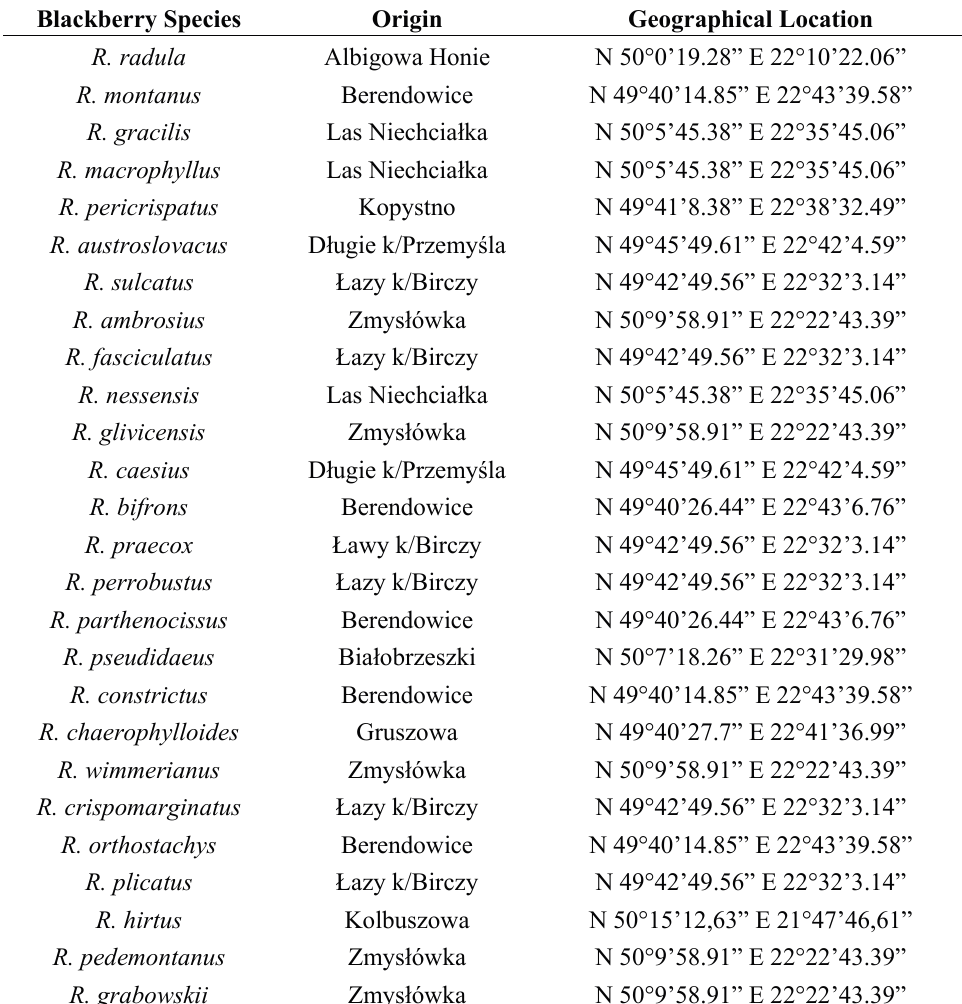
Table 4. Information about sample area of wild blackberry leaf